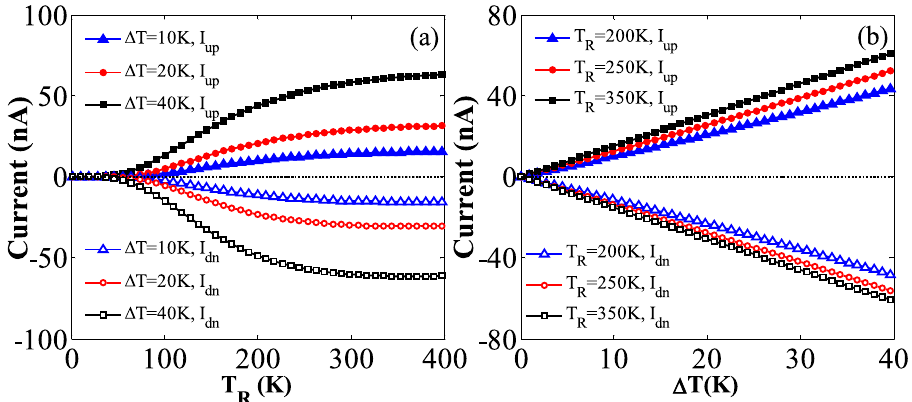
Figure 2. The thermally-induced spin currents for the considered hybrid GSNRs ( a ) the variation of the spin currents versus the right lead temperature, T R , for different temperature gradients, ∆ T = 10, 20, and 40 K. The spin-up ( I up ) and spin-down ( I dn ) currents flow in positive and negative directions, respectively (i.e., SSE) ( b ) the variation of the spin currents versus ∆ T for the right lead temperatures T R = 200, 250, and 350